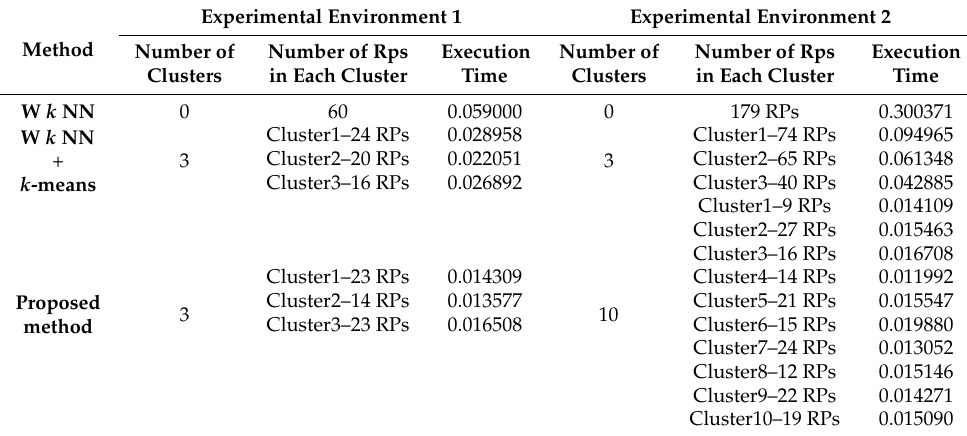
Table 3. Structure of dataset and execution time based on simulation data.